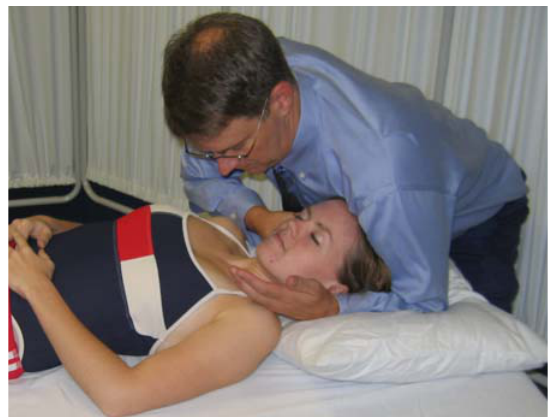
FIGURE 2. Cervical manipulation into sidebending.